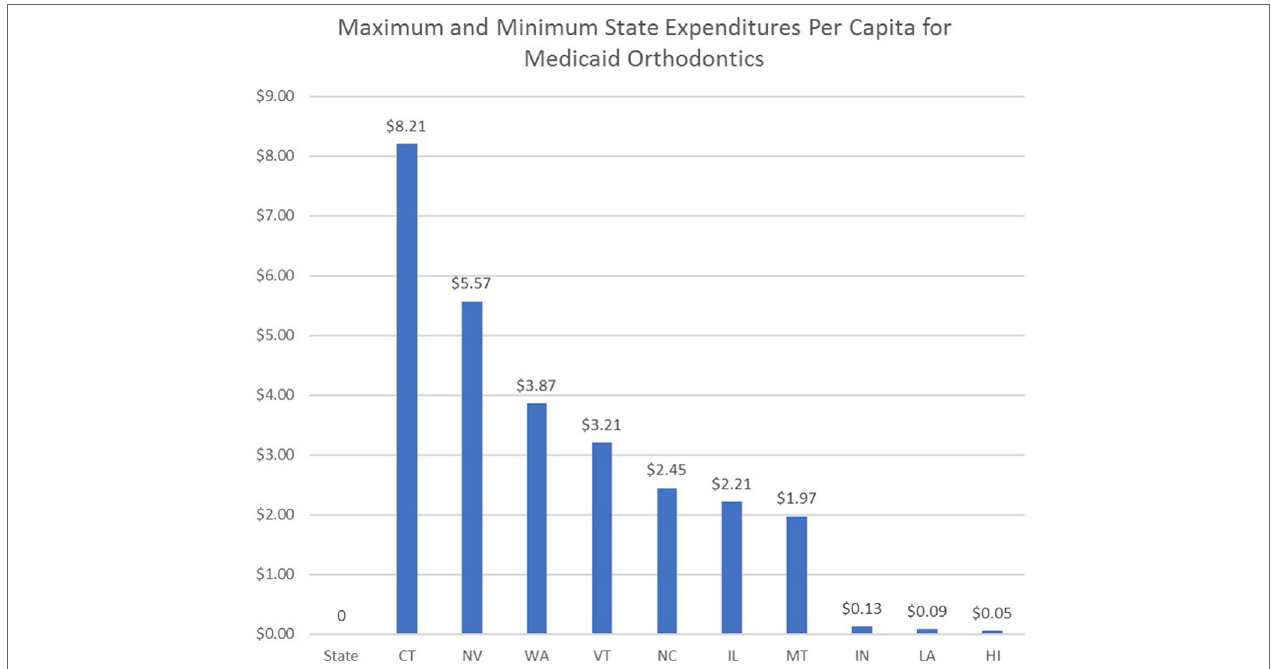
FigUre 3 | Highest and lowest state expenditures per capita for Medicaid